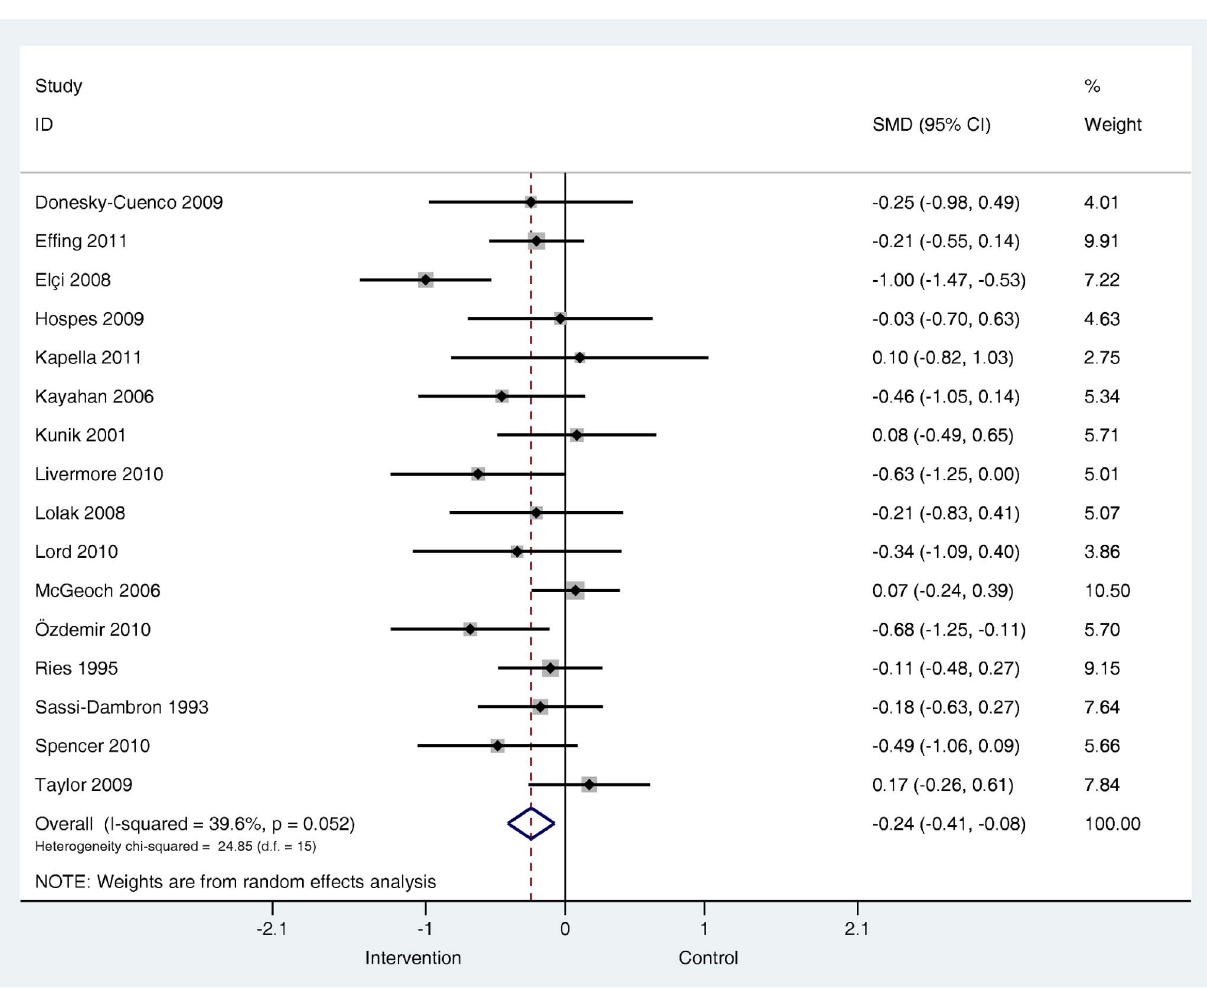
Figure 12. Effects on self-reported symptoms of depression in trials where severity of depression was unknown at baseline. Note: Random effects model used. 95% CI=95% confidence intervals; SMD=standardised mean difference.